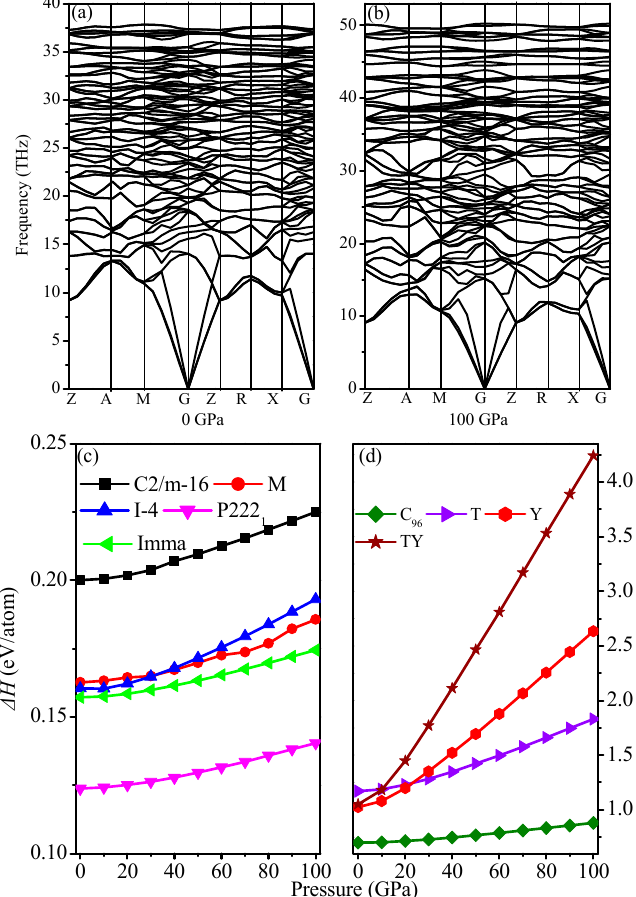
Figure 2. Phonon spectra for I4 –carbon at 0 GPa ( a ) and 100 GPa ( b ); enthalpies of I4 –carbon and other carbon allotropes relative to graphite as a function of pressure ( c , d ).